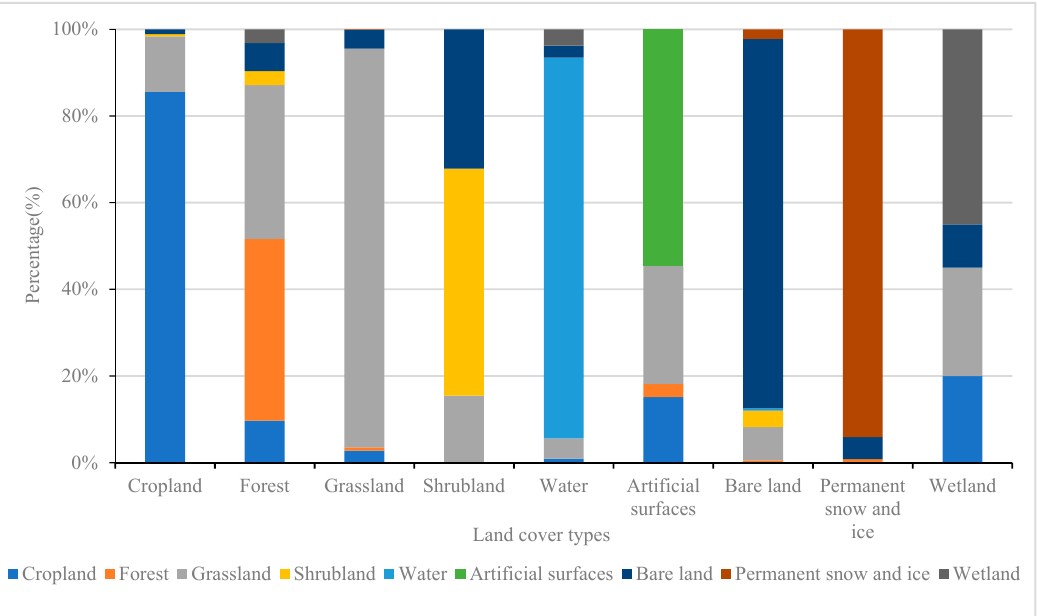
Figure 9. Multi-source landcover data fusion results in confusion of landcover types. The main landcover types of the five Central Asian countries were grassland (58.17%) and bare land (22.31%), followed by cropland (12.08%), water (2.74%), shrubland (2.68%), forest (1.05%), permanent snow and ice (0.41%), and wetland (0.37%), while artificial surfaces accounted for the lowest proportion of landcover (Figure 10). Grassland was mainly distributed in central and southeastern Kazakhstan, which accounted for about 80% of the total grassland area. The remaining 20% of grassland was more evenly distributed in eastern Uzbekistan, western Kyrgyzstan, western Tajikistan, and northern Turkmenistan. About 90% of the bare land was distributed in the southwestern part of the region, namely southwestern Kazakhstan, western Uzbekistan, and northern Turkmenistan. The bare land was mainly desert, with the Karakum Desert in Turkmenistan being the largest desert in the region. Shrublands were often distributed around bare land, with most shrubs growing in desert areas along river basins and other locations. Cropland was mainly distributed at higher latitudes in the northern plains of Kazakhstan, which accounted for 75.39% of the total cropland area. Other countries had lesser amounts of loosely distributed cropland. The water bodies of the five Central Asian countries were mainly inland lakes, including Karabogazgor Bay in Turkmenistan, Sarygamysh Lake on the border of Turkmenistan and Uzbekistan, the Aral Sea on the border of Uzbekistan and Kazakhstan, Balkhash Lake in Kazakhstan, and Issyk-Kul Lake in Kyrgyzstan. The area of permanent snow and ice was mostly distributed in the Pamirs and Tianshan Mountains on the border between central Tajikistan and the eastern part of Kyrgyzstan, which is an area of high altitude. Around 80% of the forest land was concentrated in the Altai Mountains on the eastern border of Kazakhstan.